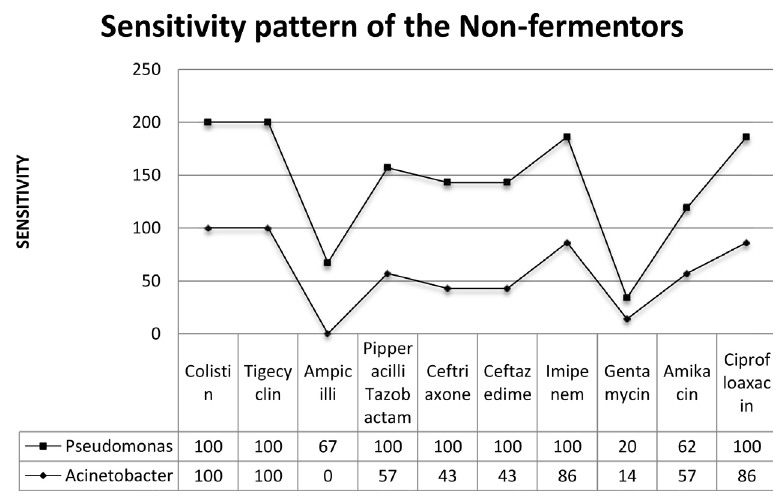
Fig. 3. Antibiotic susceptibility pattern of Non-fermentors - Acinetobacter, Pseudomonas of 52 which yielded single organism, 24 were Gram Positive cocci and 28 were Gram Negative